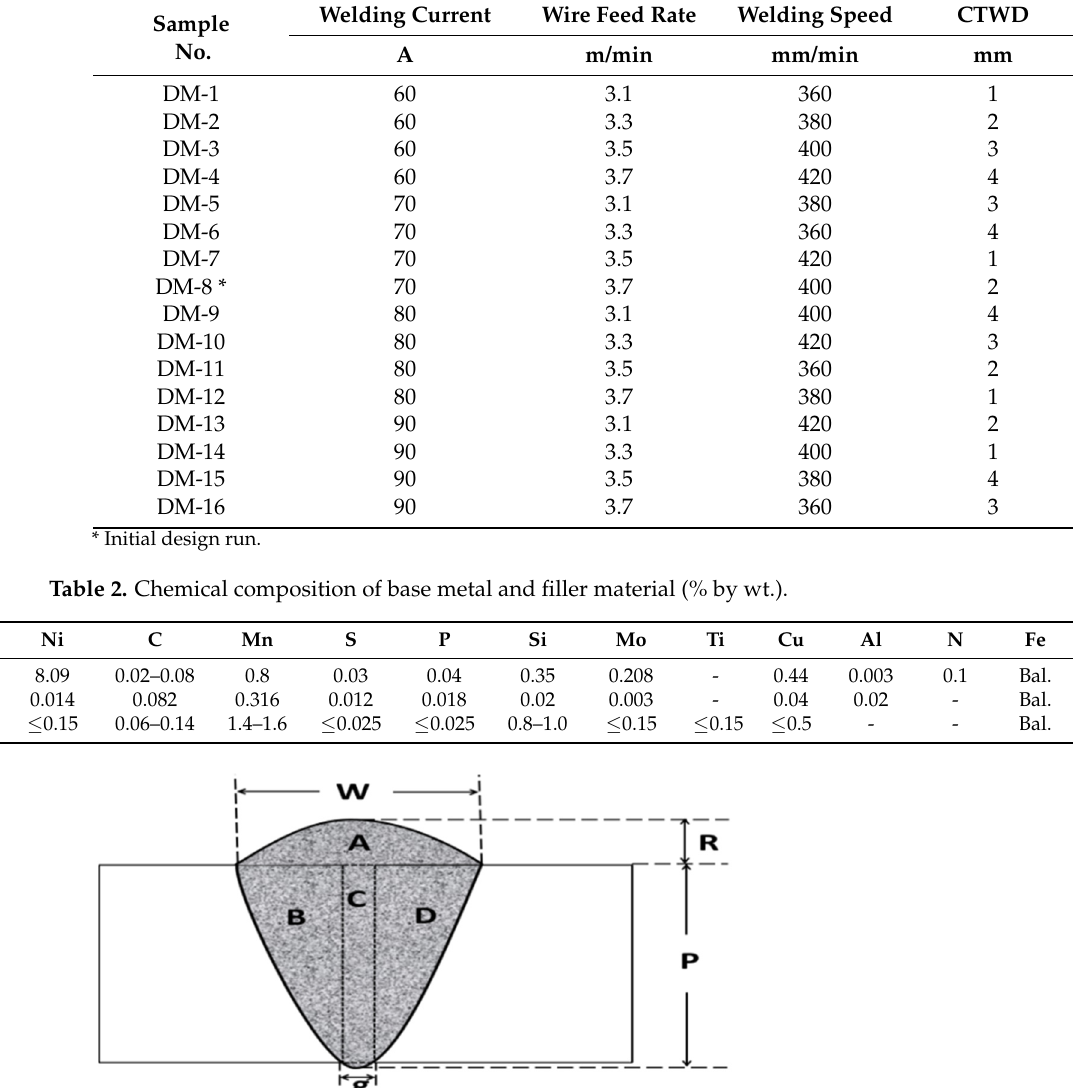
Table 1. L9 orthogonal array for the experimental run.